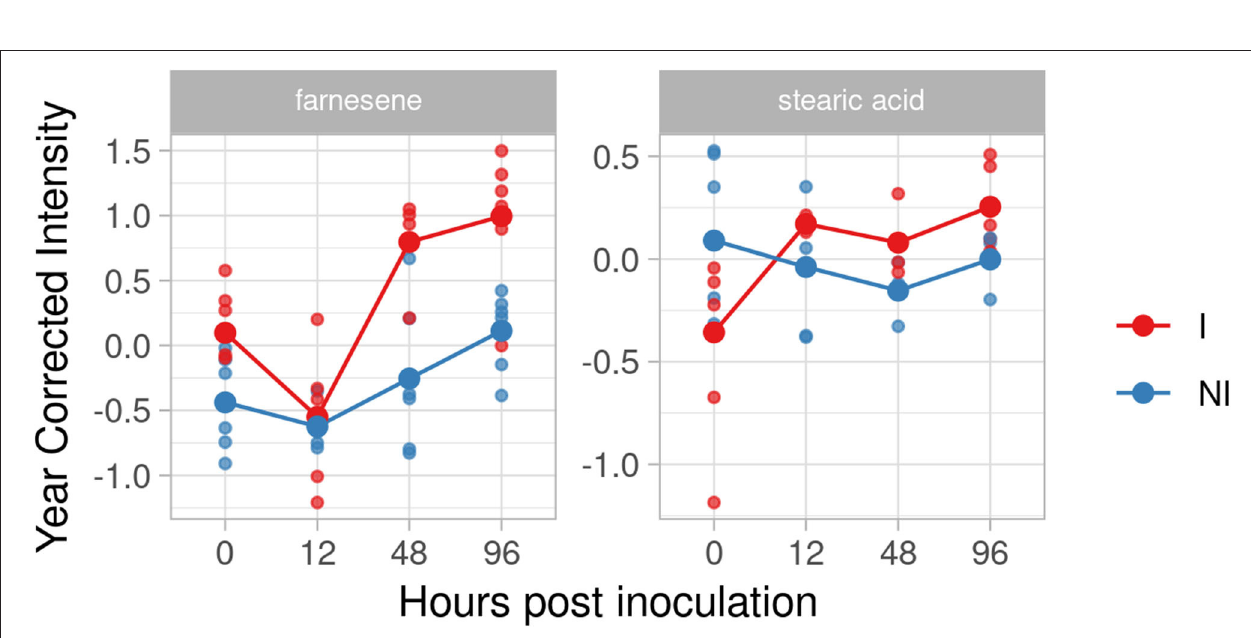
Frontiers in Plant Science |